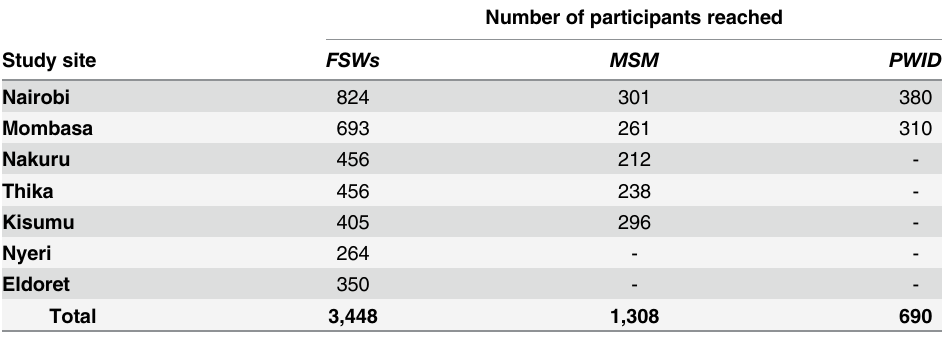
Table 1. Polling booth survey sample coverage of key populations in each study site across